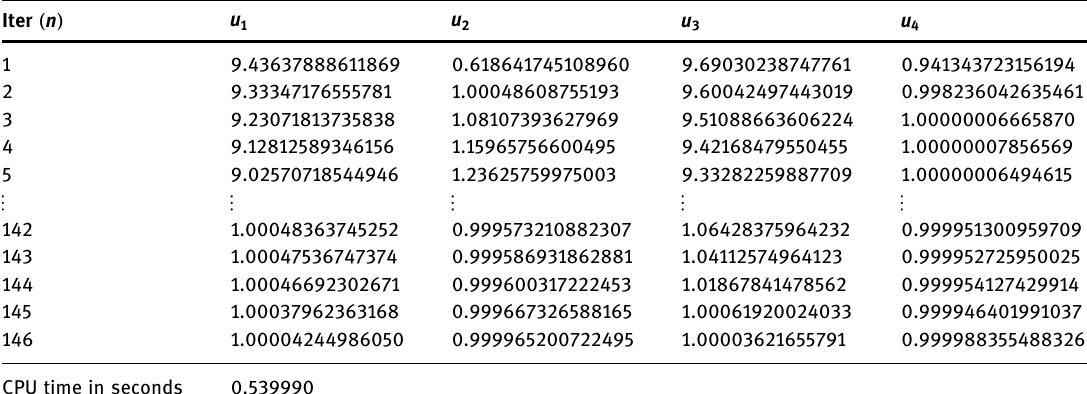
Table 8: Example 4.2: Numerical study of Algorithm 1 in [ 30 ] and